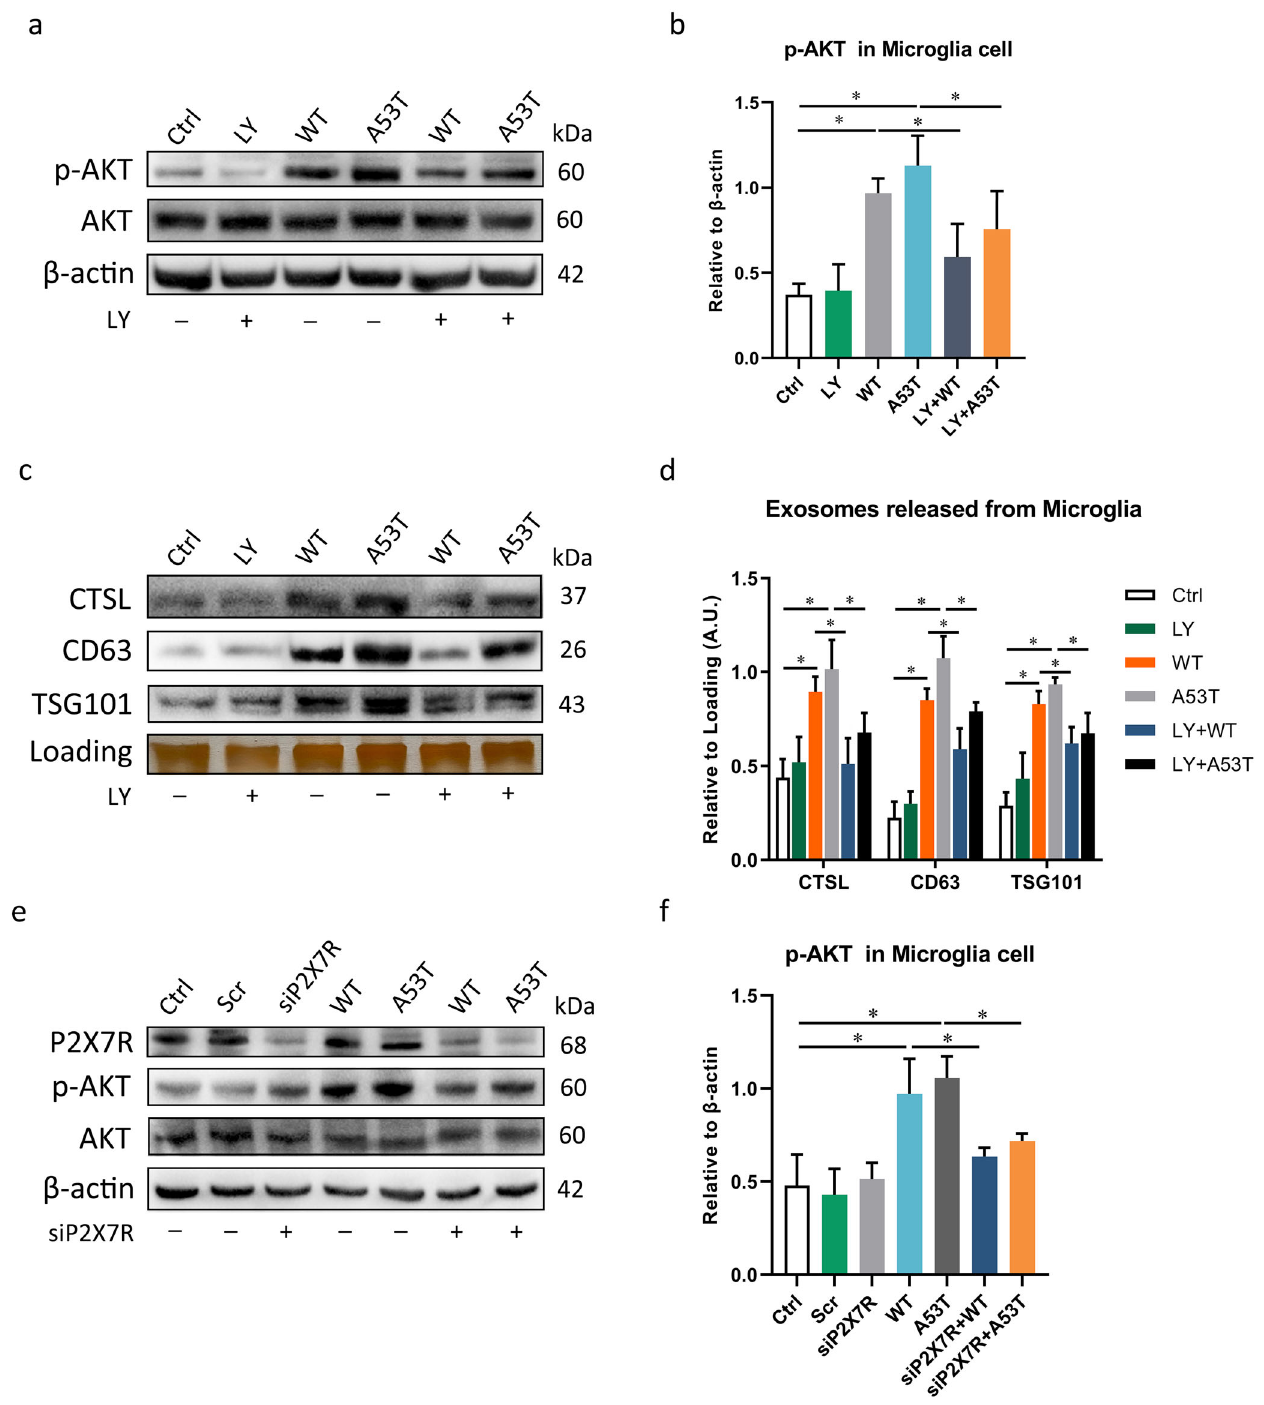
Fig. 4 P2X7R stimulates PI3K/AKT signalling in microglia in response to extracellular α -Syn oligomers, and α -Syn oligomers activate microglial CTSL-containing exosome release via the P2X7R/PI3K/AKT signalling pathway. a , b p-AKT levels in microglia were increased after treatment with WT or A53T α -Syn oligomer, with A53T α -Syn oligomer causing a more signi fi cant increase in AKT phosphorylation. Inhibition of PI3K by LY294002 (50 μ M) blocked α -Syn-induced phosphorylation of AKT ( n = 4); * p < 0.05. c , d Exosomes were isolated from the supernatants of control and α -Syn oligomer-treated microglia in the presence or absence of LY294002. CTSL, CD63, and TSG101 levels in exosome lysates were quantitatively analysed by western blotting ( n = 4); * p < 0.05. e , f p-AKT expression in microglia transfected with scramble or P2X7R siRNA after stimulation with WT or A53T α -Syn oligomer. Knockdown of P2X7R rescued the increase in p-AKT expression in BV2 cells in response to stimulation with WT or A53T α -Syn oligomer, implying that α -Syn oligomer-mediated stimulation of P2X7R is an upstream event that activates PI3K/AKT signalling and ultimately CTSL-containing exosome release ( n = 4); * p < 0.05. Ctrl = untreated control; LY = LY294002; Scr = scramble; siP2X7R = P2X7R siRNA. Error bars represent s.e.m.